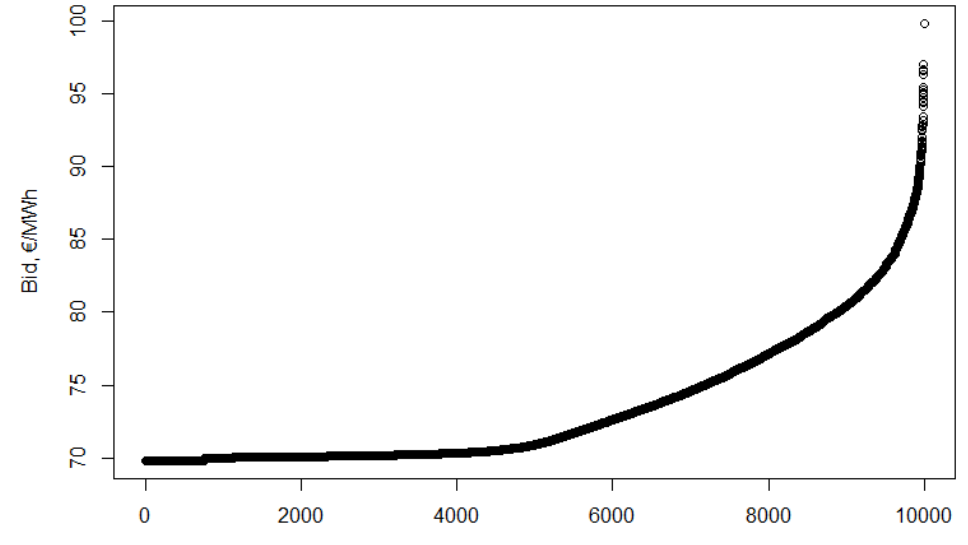
Figure A8. Sorted optimal bids, assuming F 3 bid distribution, source: own